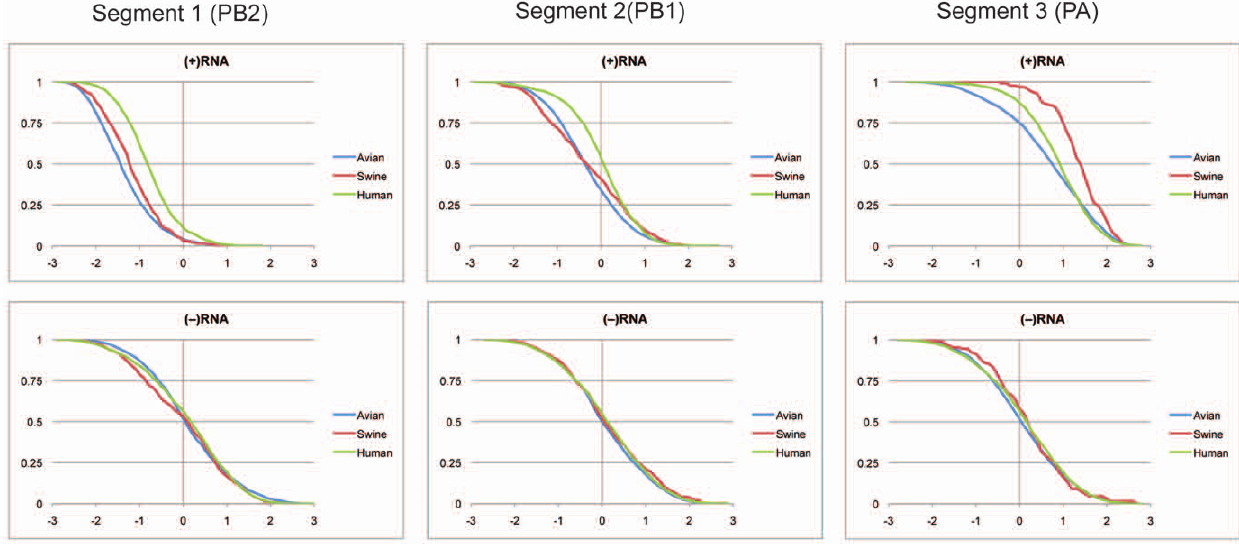
Figure 1. Cumulative distribution plots of z-scores at 37 6 C for segments 1, 2 and 3. ( + )RNA and ( 2 )RNA are shown in the top and bottom panels, respectively. Z-scores are on the x-axis with z-scores predicting more stable RNA secondary structure toward the left of the plot. Fractions of sequences with z-scores greater than or equal to the abscissa are reported on the y-axis. Avian, swine and human sequences are represented by blue, red and green coloring, respectively.